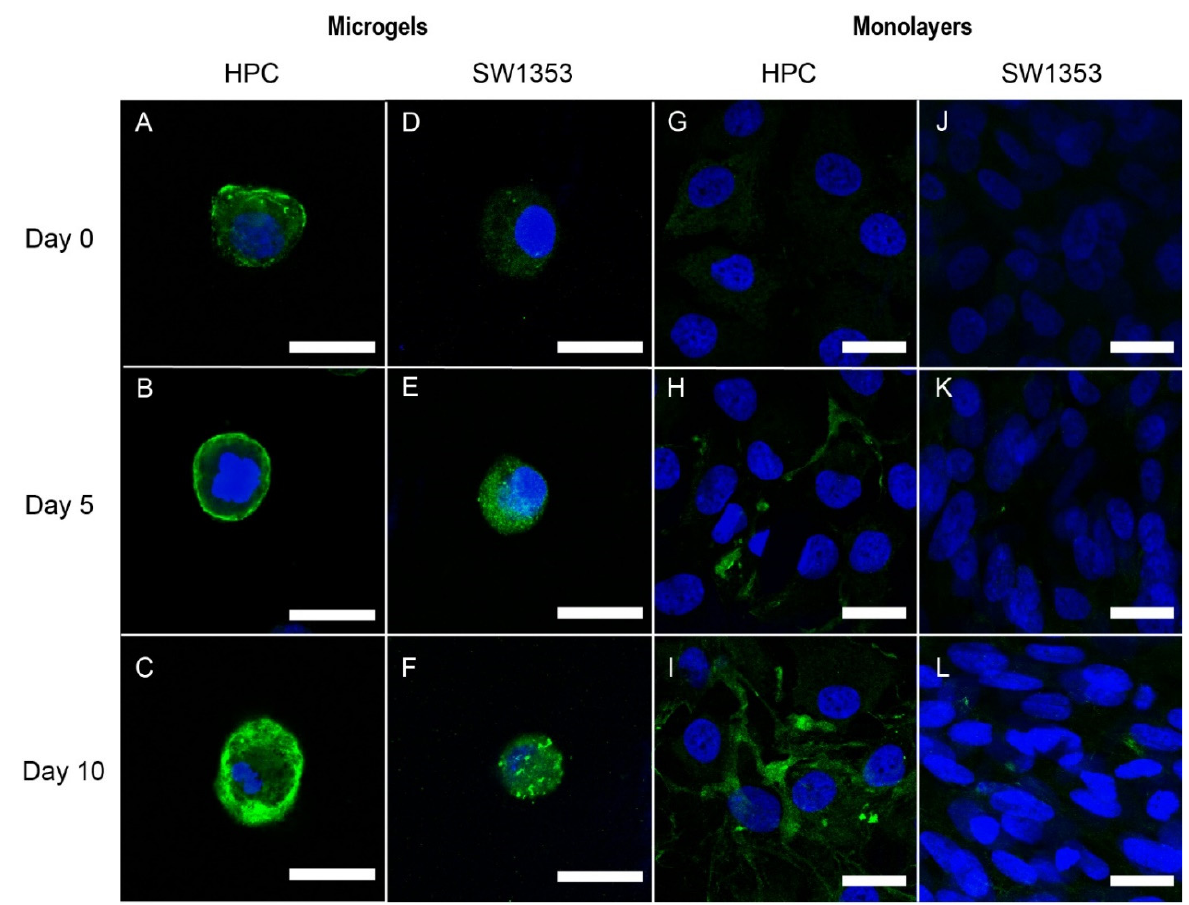
Figure 2. Human Primary Chondrocyte (HPC) ( A – C , G – I ) and SW1353 cells ( D – F , J – L ) in 1.5% w / w alginate microgels and monolayers cultured with 50 µ g/mL ascorbate. Cells were stained for collagen VI (green) and nuclei (blue). Cells were imaged on days 0, 5, and 10. Scale bars are 20 µ